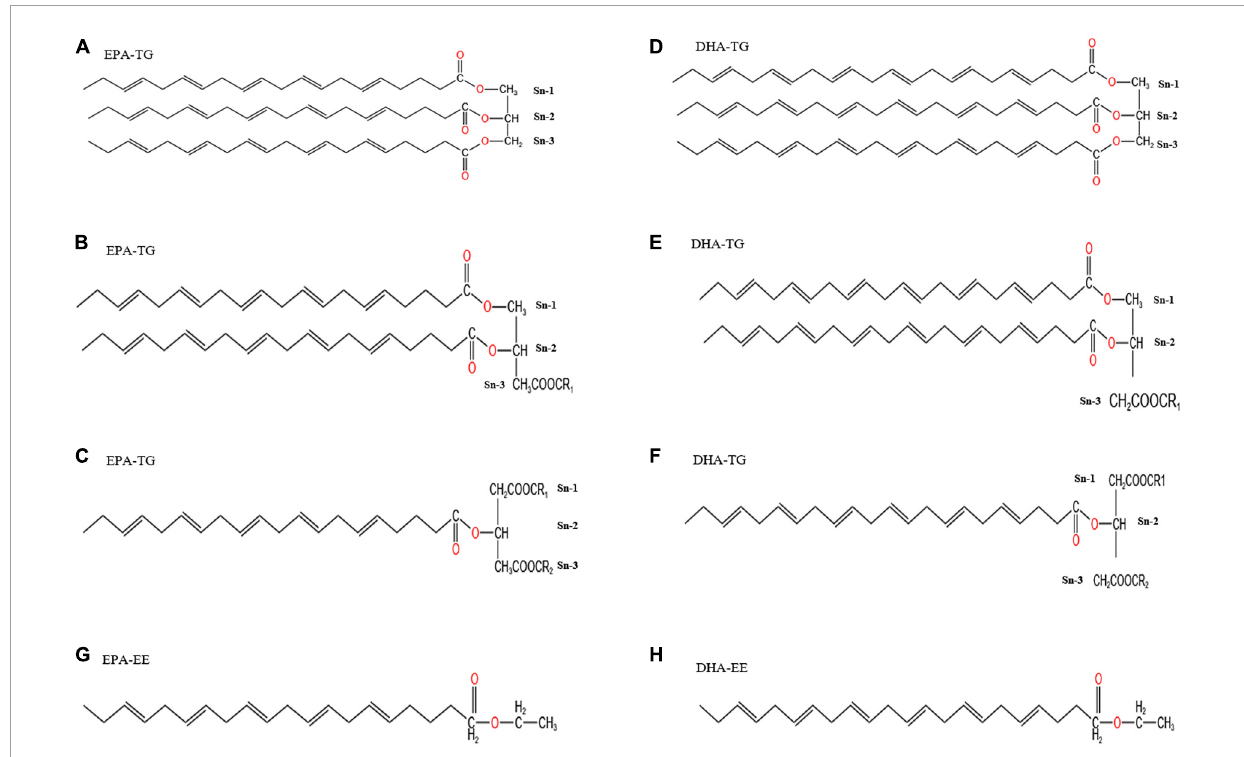
FIGURE1 Chemical structure diagrams of EPA/DHA as TGs and EEs. Panels (A–F) show the chemical structures of EPA/DHA as TGs, indicating that it is possible for EPA/DHA to locate at sn -1, sn -2, and sn -3 in TGs. EPA/DHA in fish oil is more likely to locate at sn -2. Every TG could have one, two or three EPA/DHA. Panels (G,H) show the chemical structures of EPA/DHA as EEs.